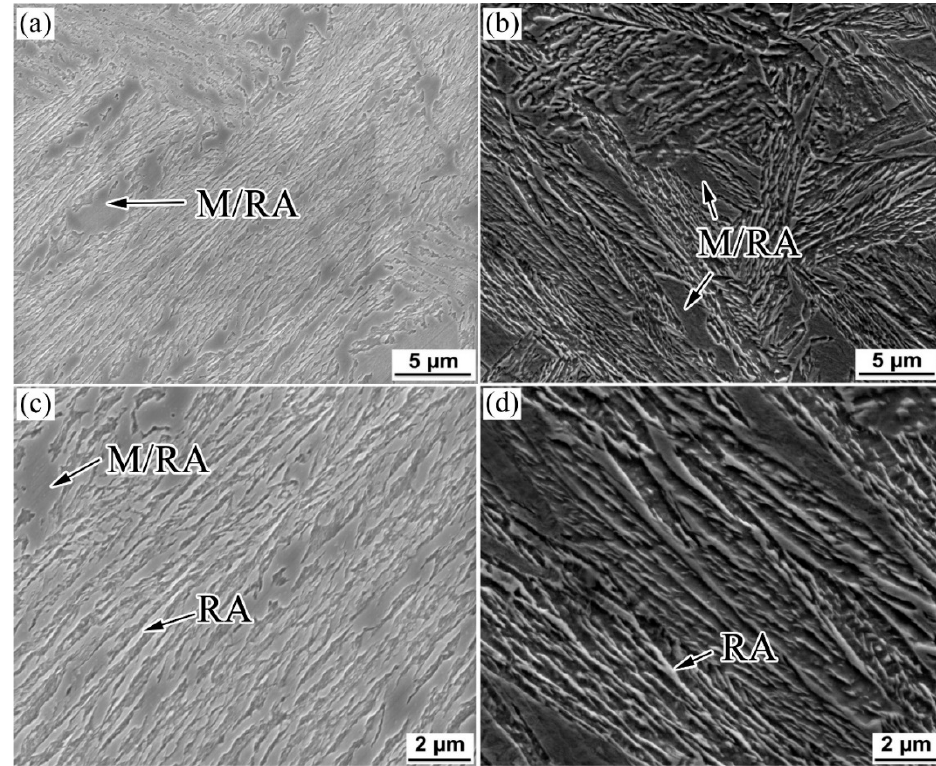
Figure 2. SEM micrographs of the investigated steel for ( a , c ) one-step and ( b , d ) two-step treatments.